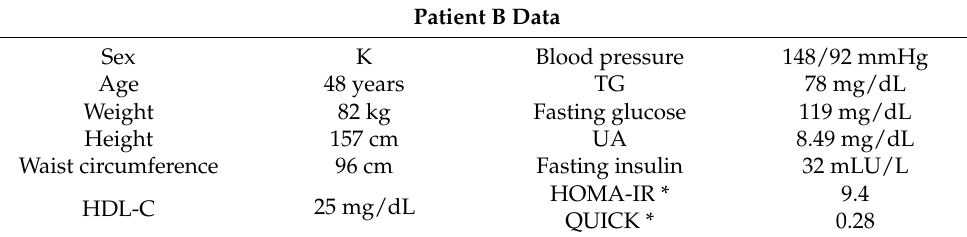
Table 7. Patient B